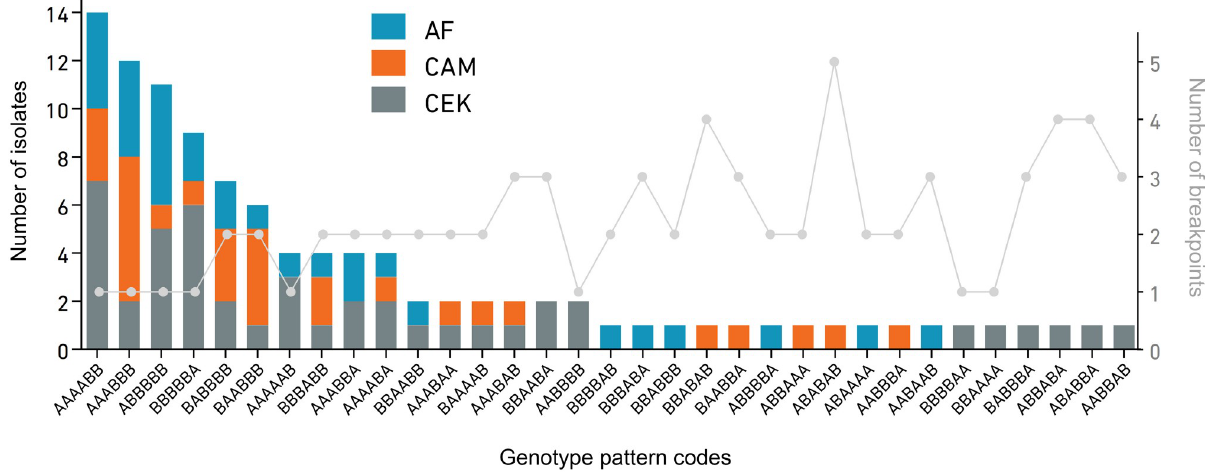
Fig 6. Number of isolates with each genotype pattern code (left y axis) and the origin of each isolate, together with the number of recombination breakpoints on the right y axis. Isolates resulting from multiple recombination events were obtained less frequently. The negative correlation between the number of recombination events in a recombinant virus and the abundance of those recombinants in samples was statistically significant (Spearman’s correlation, r s = -0.55, 95% confidence interval = -0.7579 to -0.2490, two-tailed p value = 0.0008).